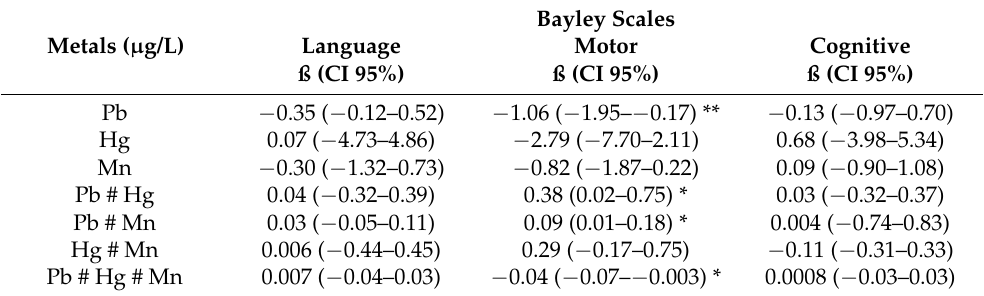
Table 3. Joint association of blood lead, mercury, and manganese with language, motor, and cognitive development in children 1–12 months of age a